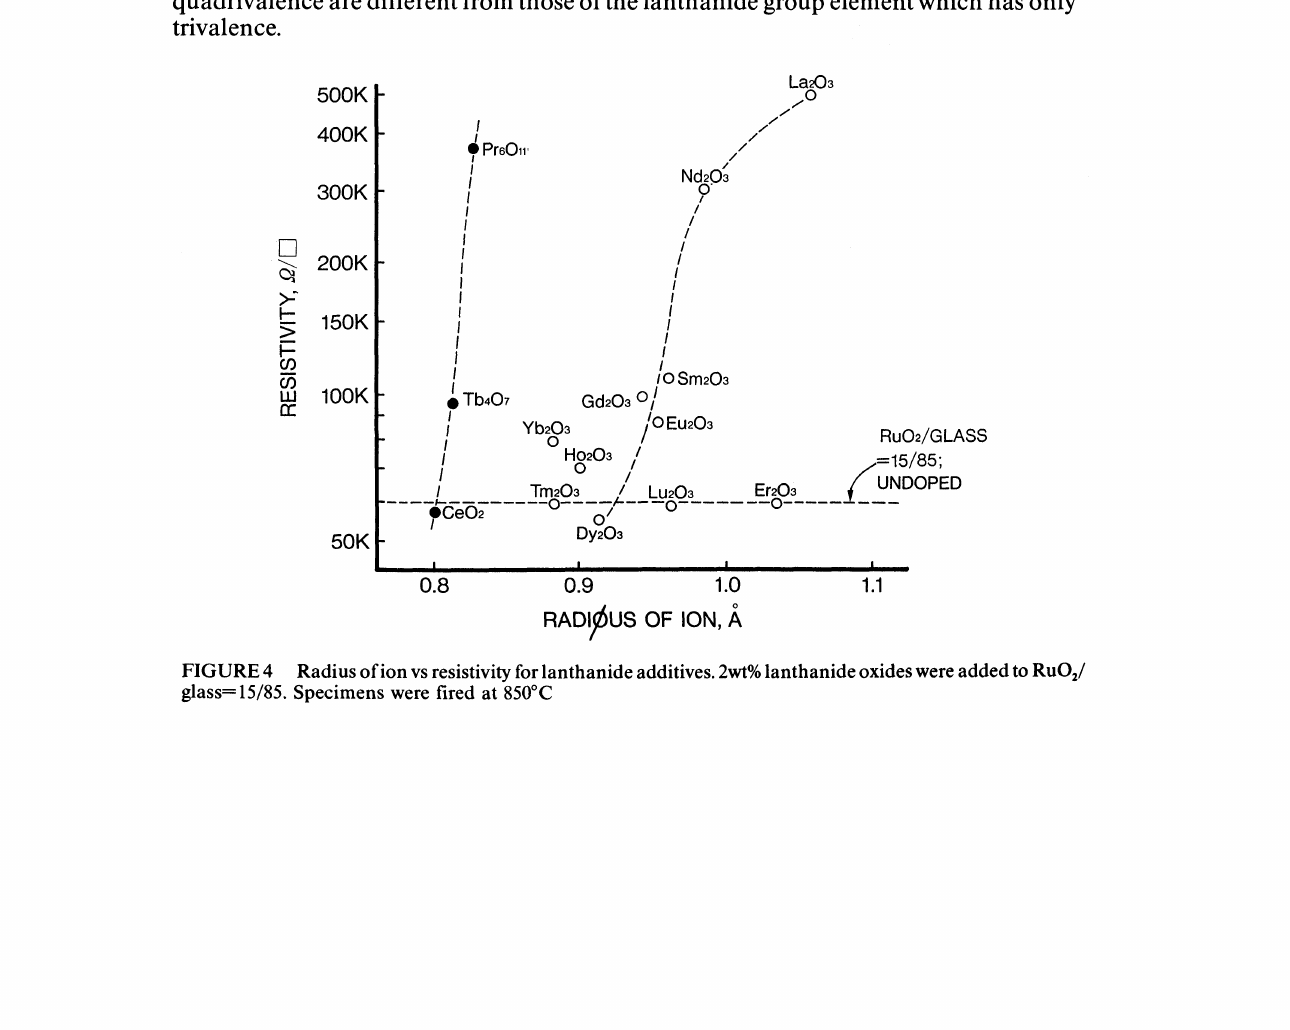
FIGURE 4 Radius of ion vs resistivity for lanthanide additives. 2wt% lanthanideoxides were added to RuO2/ glass=15/85. Specimens were fired at